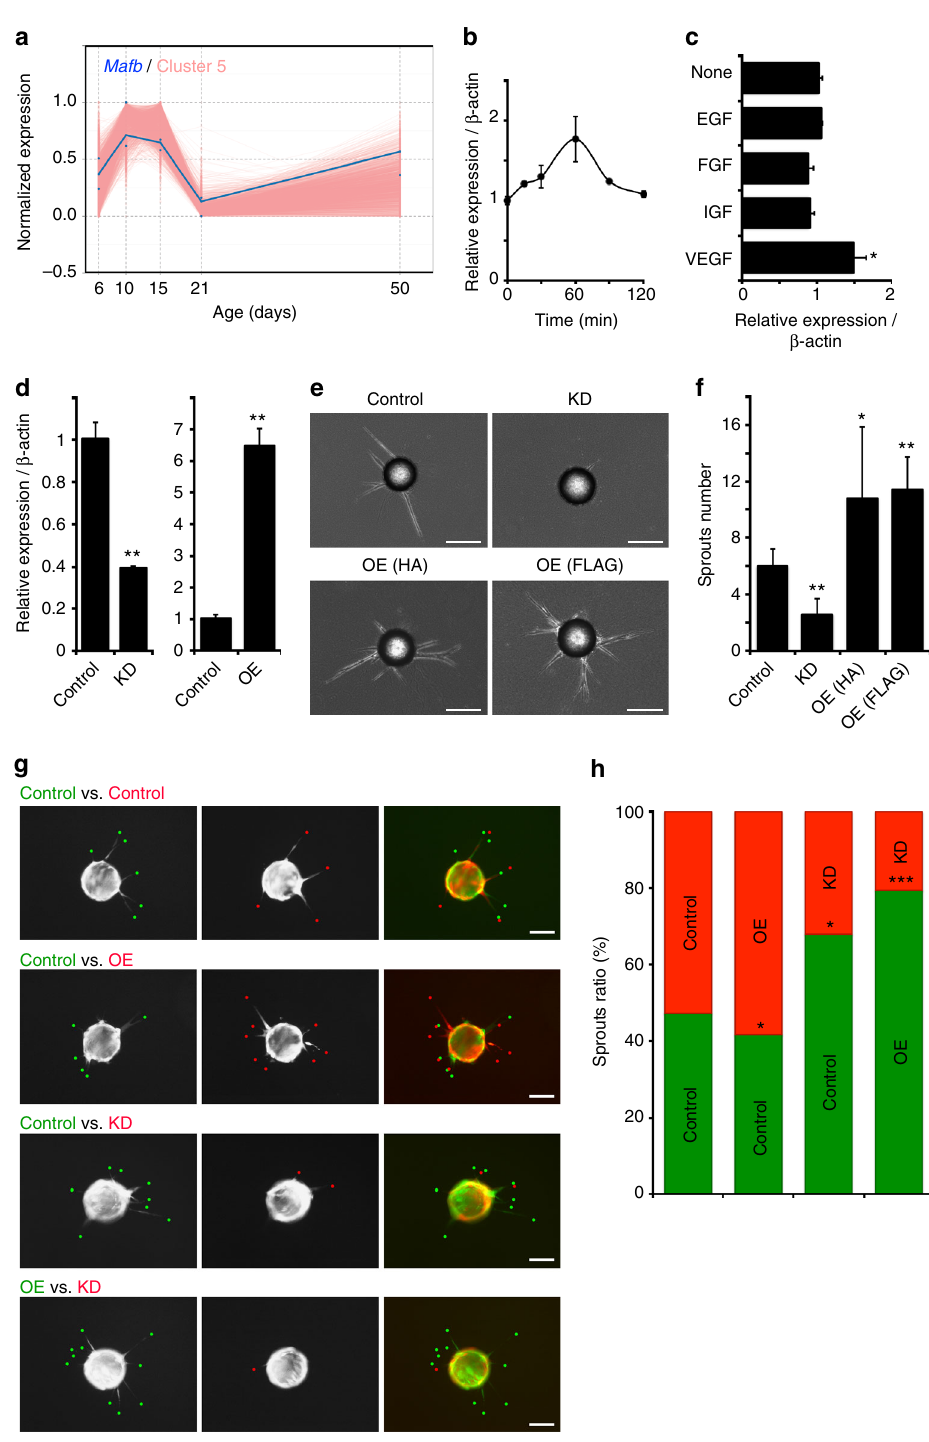
Fig. 3 MafB is a novel TF regulating sprouting angiogenesis in vitro. a Normalized expression of Mafb ( blue ) among cluster 5 genes ( pink ) in postnatal retinal ECs. b , c RT-qPCR analysis of relative Mafb expression in MS1 ECs after treatment of complete EGM-2 media ( b ) or single growth factors, as indicated ( c ). n = 4, * P < 0.05; unpaired Student ’ s t -test. Error bars represent mean ± s.e.m. d RT-qPCR analysis of relative Mafb expression in MS1 EC lines infected with lentivirus containing no-insert (Control), Mafb -targeting shRNA (KD, knockdown) or HA-tagged Mafb cDNA (OE, overexpression). n = 3, ** P < 0.001; unpaired Student ’ s t -test. Error bars represent mean + s.e.m. e Three-dimensional fi brin gel bead sprouting assay with stable MS1 lines expressing no insert (Control), Mafb -targeting shRNA (KD), HA-tagged Mafb cDNA (OE (HA)), or FLAG-tagged Mafb cDNA (OE (FLAG)). Representative spheroids are shown for each condition at culture day 3. Scale bars represent 170 μ m. f Average number of sprouts per spheroid in each condition of e . n = 12, Error bars represent mean + s.d. * P < 0.05, ** P < 0.001; unpaired Student ’ s t -test. g Competitive sprouting assay with 1:1 mixture of differentially labeled (eGFP or tdTomato) MS1 lines expressing no insert (Control), Mafb -targeting shRNA (KD) or HA-tagged Mafb cDNA (OE). Representative spheroids are shown for each condition at 8 h after the fi broblast seeding. Scale bars represent 100 μ m. h Ratio of differentially labeled sprouts in each condition shown in g . n = 12, * P < 0.05, *** P < 0.0001; unpaired Student ’ s t